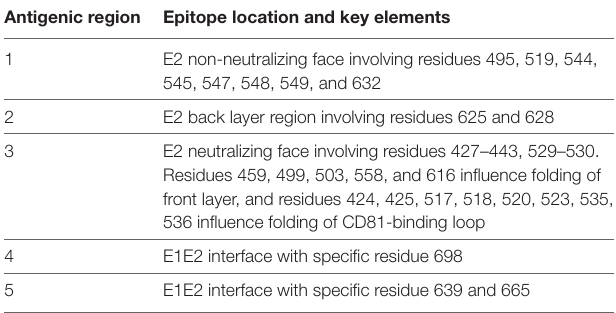
Table 2 | Immunogenic clusters as defined by antigenic regions. antigenic region epitope location and key